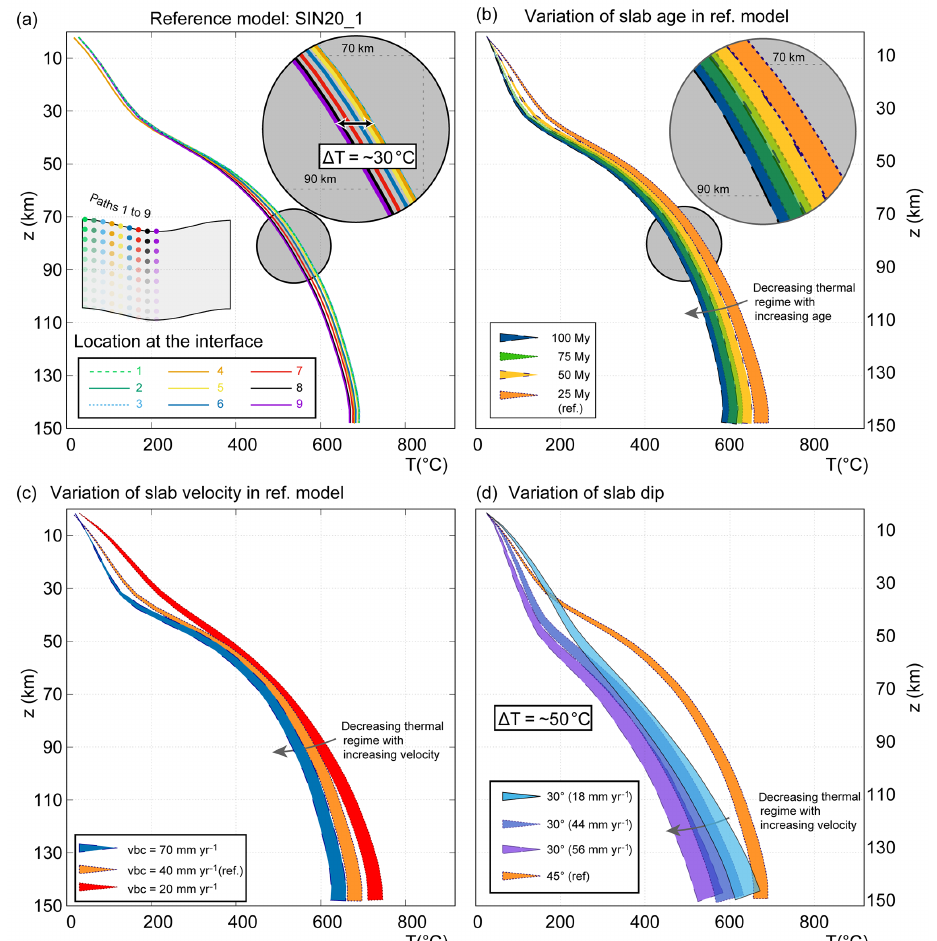
Figure 4. (a) Depth–temperature path retrieved at the plate interface of the reference model (SIN20_1) with a downgoing plate velocity of 40mmyr − 1 . The relative position of the depth–temperature path is given (middle and edge). The zoom allows for a better evaluation of the relative position of the depth–temperature paths and the differences in thermal regime along-strike. The inset sketch gives the position of the sampled point along the slab with respect to depth (the color shading depicts deepening); (b) Variation in thermal regime with respect to slab age. The blue, green, yellow and orange curves give the temperature range in the model (ca. 30 ◦ C); (c) investigation of different subducting rates for the reference experiment; blue is 70mmyr − 1 and red is 20mmyr − 1 ; (d) variation in temperature for a subduction angle of 30 ◦ investigated for different subduction